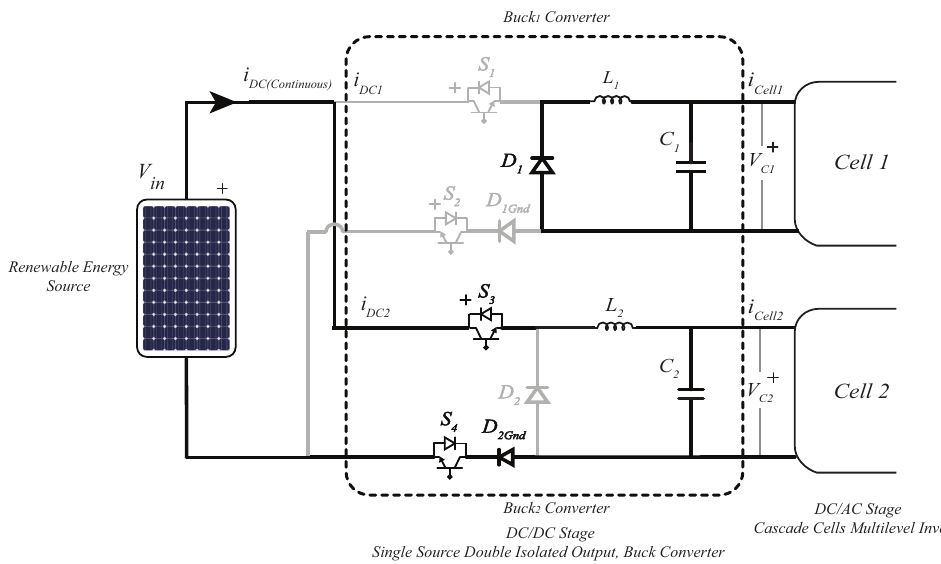
Figure 8. Proposed buck variant topology in switching state S 1 = 0, S 2 = 1 with highlighted currents paths.